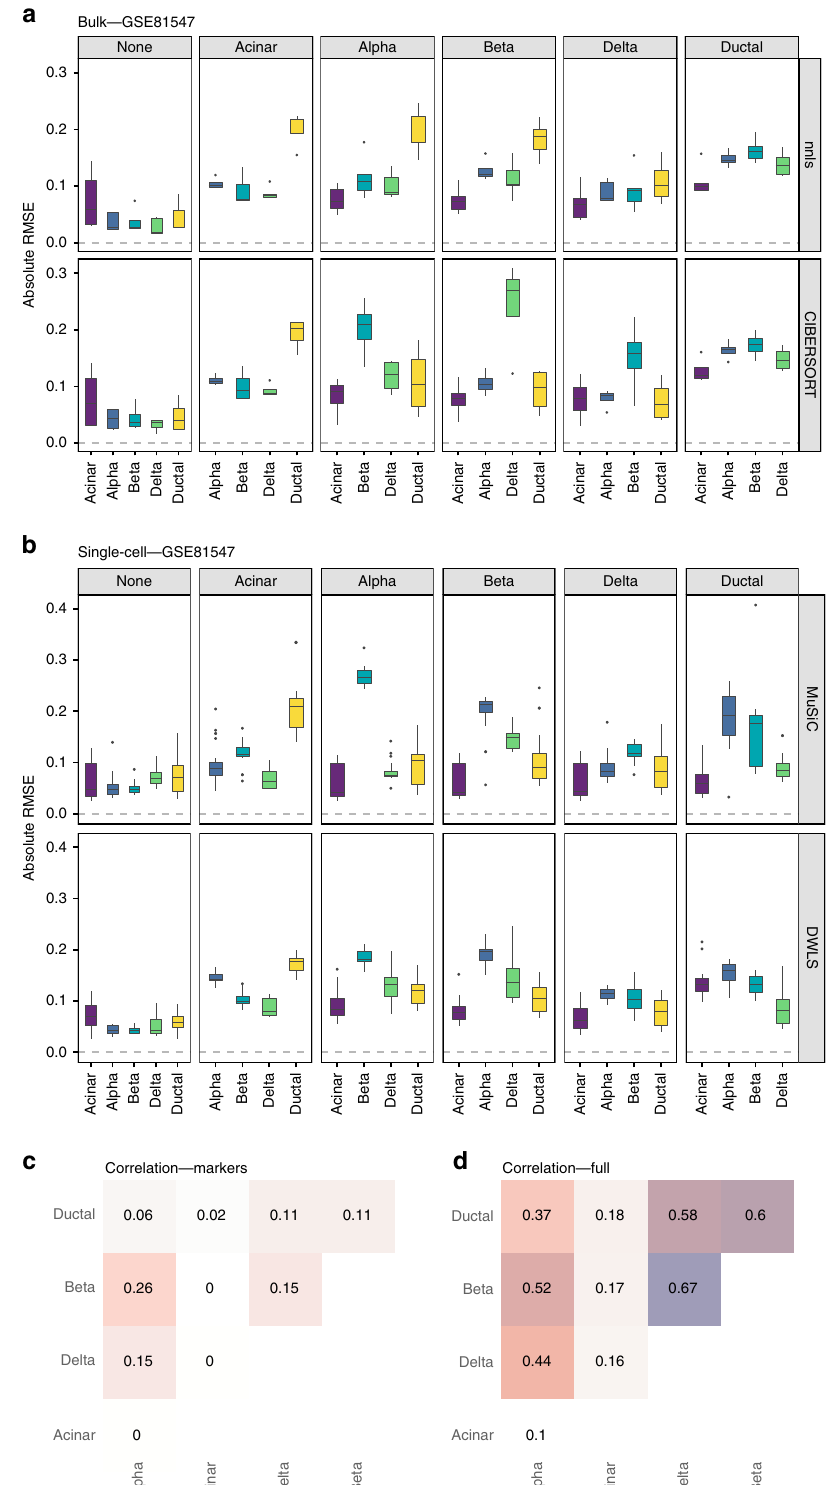
Fig. 6 Effect of cell type removal on the deconvolution results for the GSE81547 dataset (100-cell mixtures; linear scale). a Results using bulk deconvolution methods (nnls and CIBERSORT); b results with deconvolution methods using scRNA-seq data as reference (MuSiC and DWLS). c Pairwise Pearson correlation values between expression pro fi les for the different cell types, using a subset of the reference matrix containing only the markers used in the bulk deconvolution; d pairwise Pearson correlation values between complete expression pro fi les for the different cell types. In a , b , each gray column represents a speci fi c cell type removed. Each data point conforming a boxplot represents a different scaling/normalization strategy